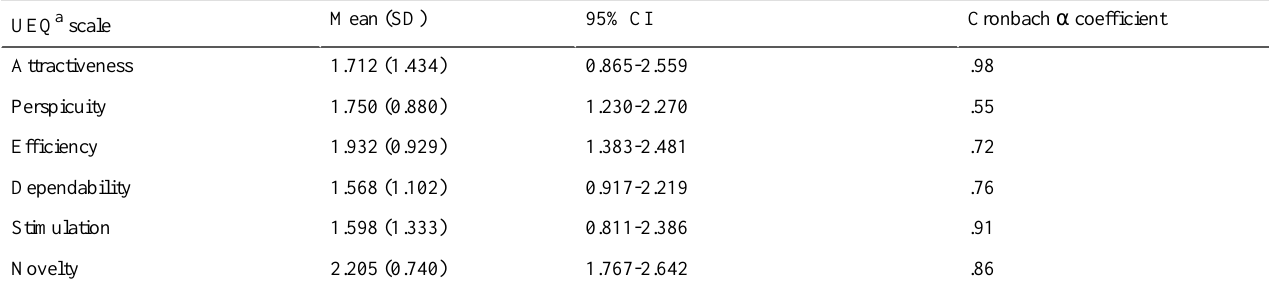
Table 1. PediAppRREST app